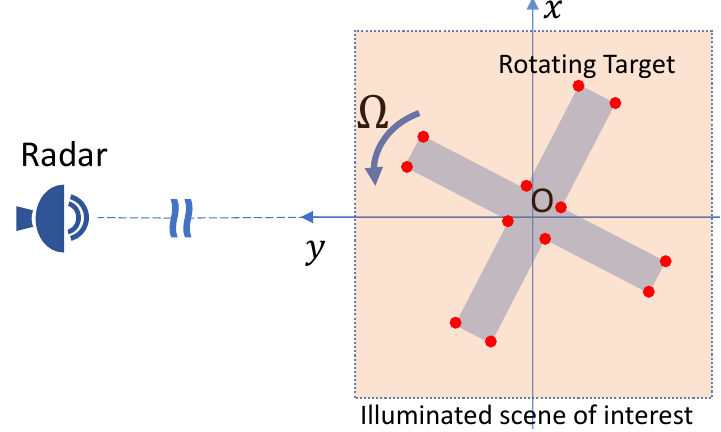
Figure 1. The radar-target geometry of the considered radar imaging problem of a rotating